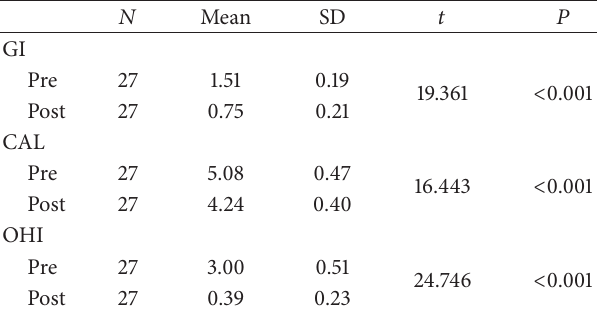
Table 2: Correlation of the mean gingival index scores, mean CAL scores, and mean OHI scores before and after nonsurgical periodontal therapy.